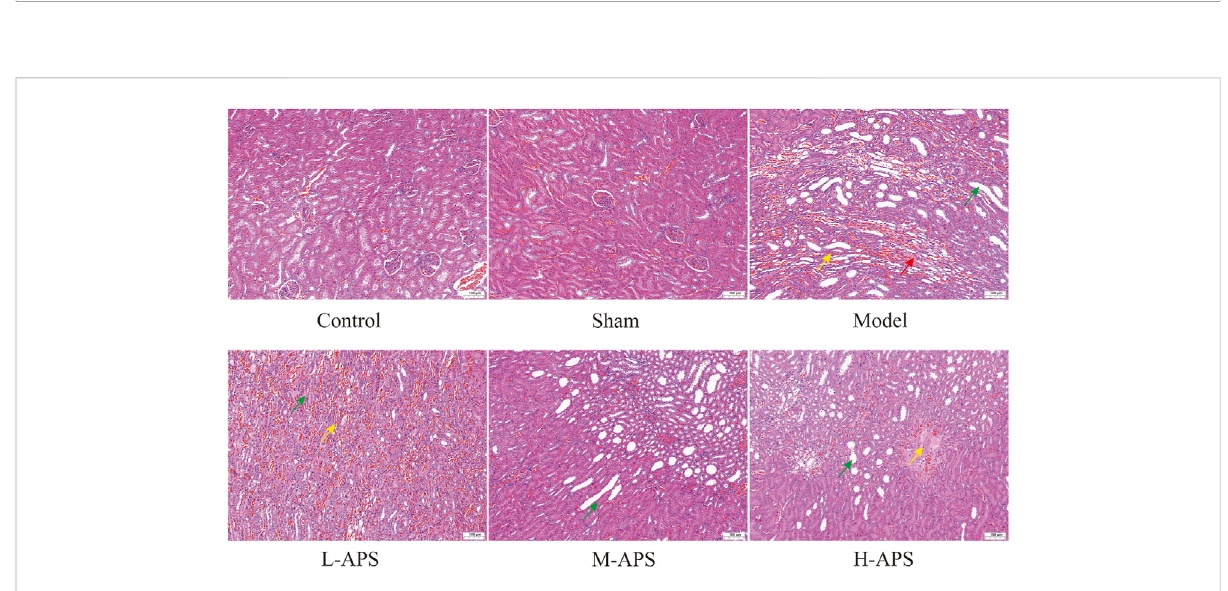
FIGURE 2 H&E staining detection of the effect of APS on renal tissue injury in septic rats. Green arrow, dilated tubules; red arrow, protein cast; yellow arrow, congestion of blood vessels. The scale bar is 100 μ